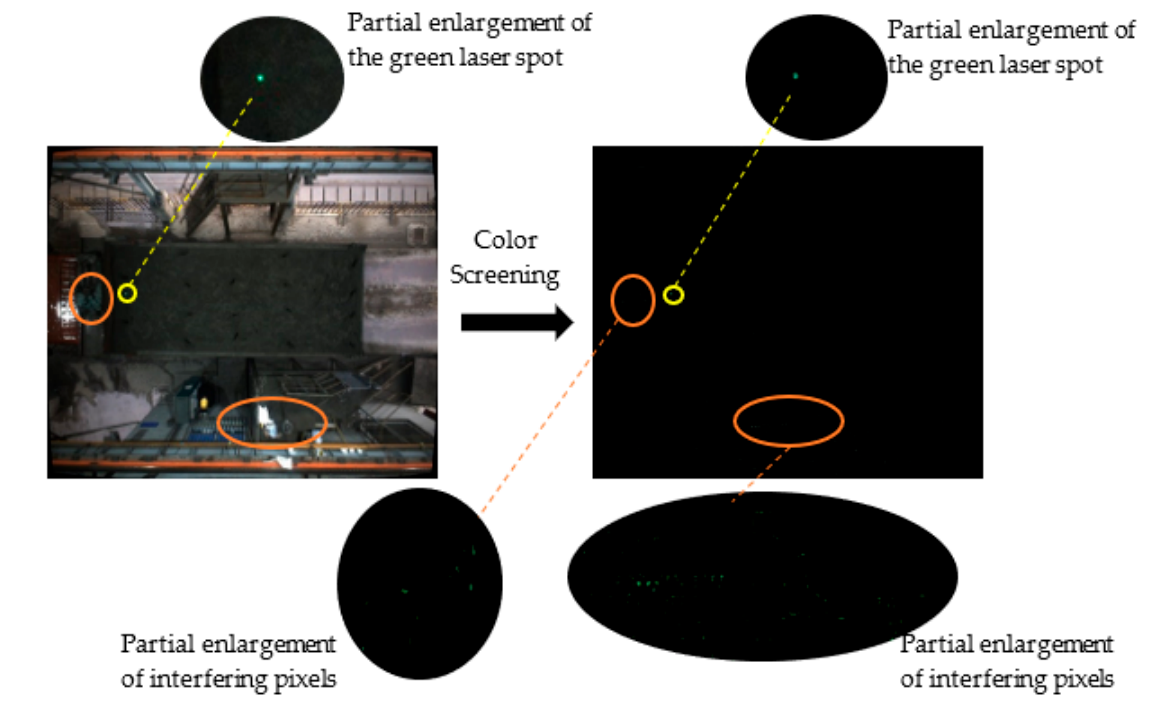
Figure 19. The original image after color screening.